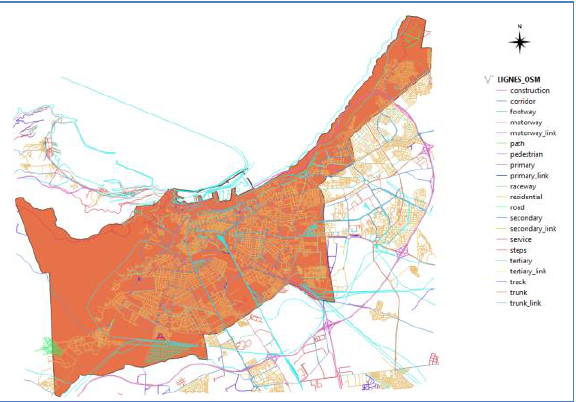
Figure 3 . OSM data processed and rectified on the road network of the city of